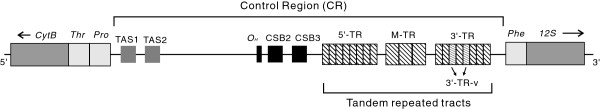
An illustration of the location of three motif types in P. cornutus control region. CytB: Cytochrome b gene; Thr, Pro, Phe: tRNA of Threonine, Proline, Phenylalanine; 12S: Small subunit ribosomal DNA.